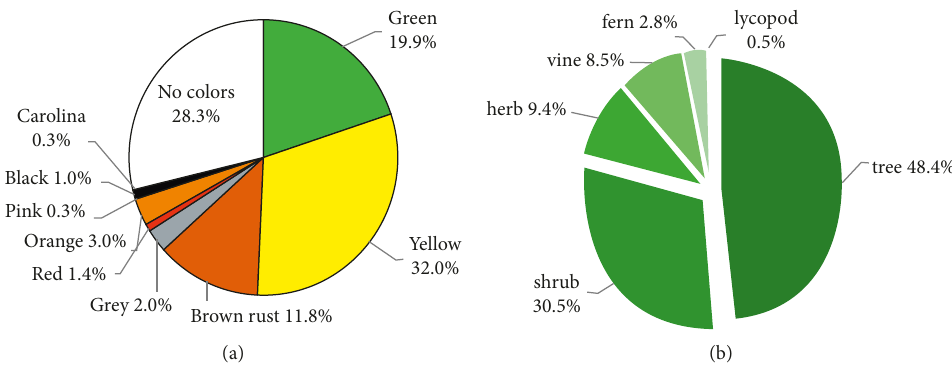
Figure 2: Percentage of colors group expression of leaf samples (a) and vegetation life forms of colored leaves